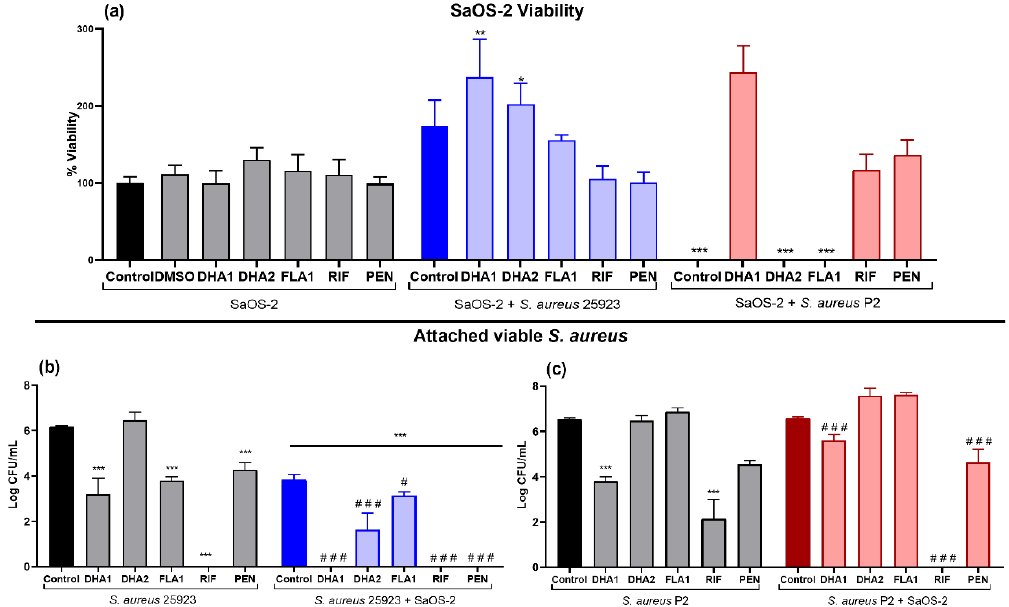
Figure 6. E ff ect of the two DHA derivatives ( DHA1 and DHA2 ), the flavonoid derivative ( FLA1 ) and two control antibiotics ( RIF and PEN ) on competitive colonization on titanium coupons pre-incubated for 24 h with SaOS-2 cells. ( a ) Results corresponding to the viability of SaOS-2 cells when cultured on titanium coupons alone (SaOS-2, grey bars), or co-cultured with S. aureus ATCC 25923 (SaOS-2 + S. aureus 25923, blue bars), or P2 clinical S. aureus strain (SaOS-2 + S. aureus P2, red bars); ( b , c ) Results corresponding to the e ff ects on attached viable S. aureus measured when the ATCC 25923 ( b ) or P2 clinical S. aureus strain ( c ) was used. Percentage of viability of SaOS-2 cells was calculated with respect to untreated controls after 24-h incubation on titanium coupons, using glow luminescence signal resulting from ATP production by viable SaOS-2 cells. Viable counts (log of CFU / mL) of S. aureus ATCC 25923 or the clinical strain P2 were also measured after 24-h incubation on titanium coupons when co-cultured with SaOS-2 cells. “*” represents di ff erences with the corresponding monoculture control and “#” represents di ff erences with the corresponding co-culture controls (* p < 0.05; ** p < 0.01; *** p < 0.001) / ( # p < 0.05; ## p < 0.01; ### p < 0.001). Results are expressed as mean ± SEM of three technical replicates in experiments repeated three